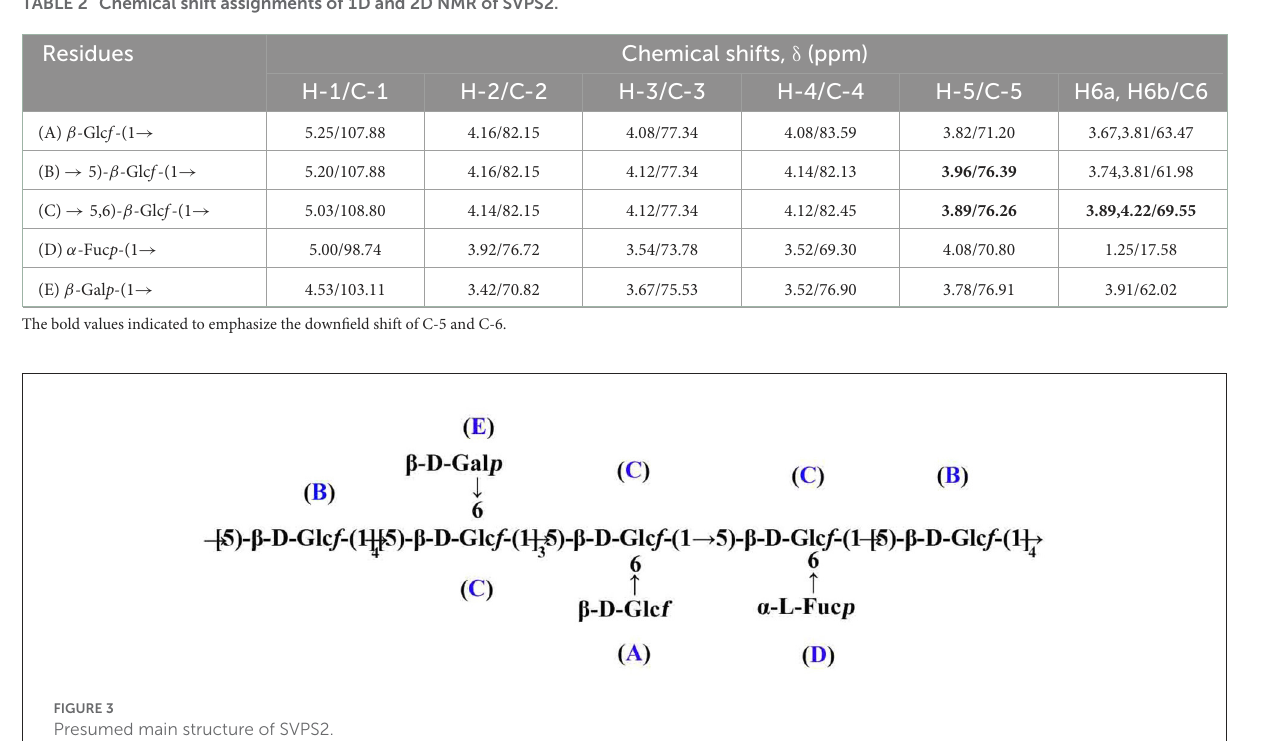
TABLE 2 Chemical shift assignments of 1D and 2D NMR of SVPS2.